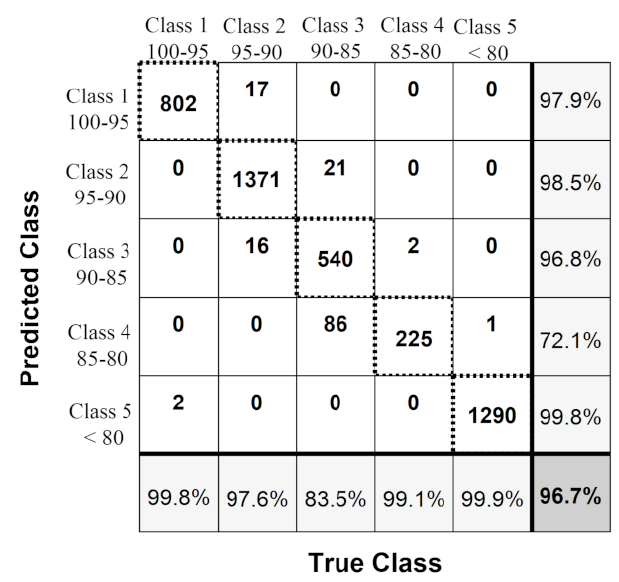
Figure 19. Confusion matrix for model validation with NCR 18650 GA lithium-ion cell under dynamic load profile. The diagonal cells are correctly classified buffers. The last row with gray background is the TPR. The last column with gray background is the precision per class. The bottom right cell with dark background is the total